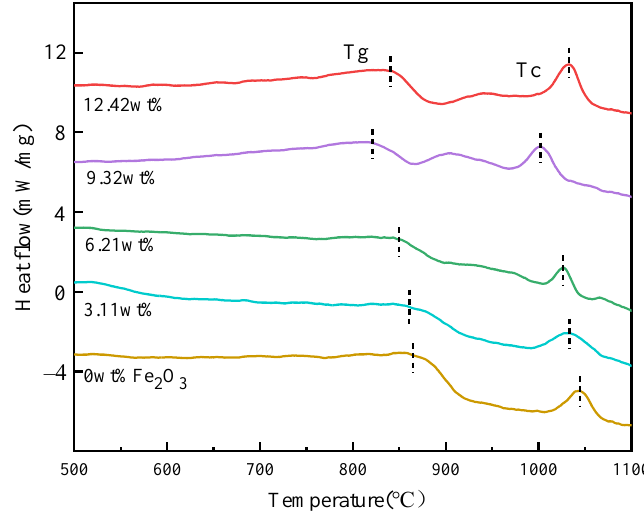
Figure 1. DSC curves of the glass samples with the heating rate of 10 °C/min in air. The intensity of the crystallization peak at Tc became sharp, suggesting that Fe 2 O 3 promotes the crystallization precipitation. When the Fe 2 O 3 content exceeds 9.32 wt%, a relatively weak exothermic peak appears near 950 °C, showing the precipitation of different crystalline phases. The results here are consistent with the subsequent analysis in XRD.